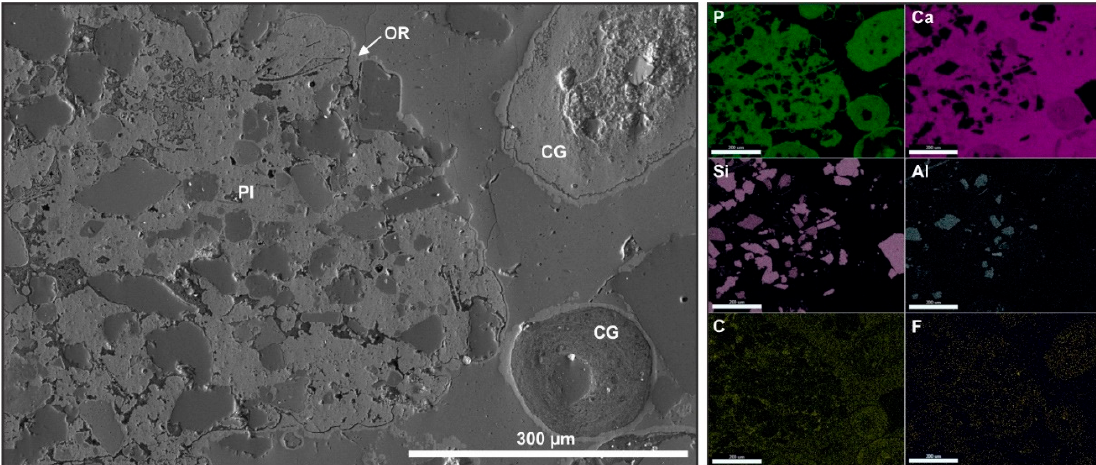
Figure 10. Detailed SEM image of sample MH6 centered between the edge of a phosphatic intraclast (PI) and two apatite coated grains (CG), acquired with ET detector BSE mode, and SDD-EDS elemental maps of select major and trace elements. On the left side of the image is the edge of a phosphatic intraclast containing aluminosilicate and quartz silt-size grains. Organic matter can be seen within the intraclast around siliciclastic grains, likely adsorbed onto the crystal surface. The intraclast has an irregular but sharp contact with an apatite overgrowth rim (OR). A rim can also be seen in the other coated grains and quartz grains in this picture. A trace amount of fluorine is mapped in association with the apatite, suggesting fluorapatite.